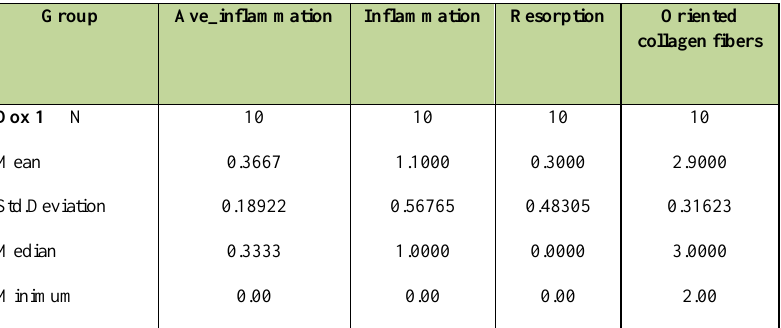
Table 1. The general characteristics of the